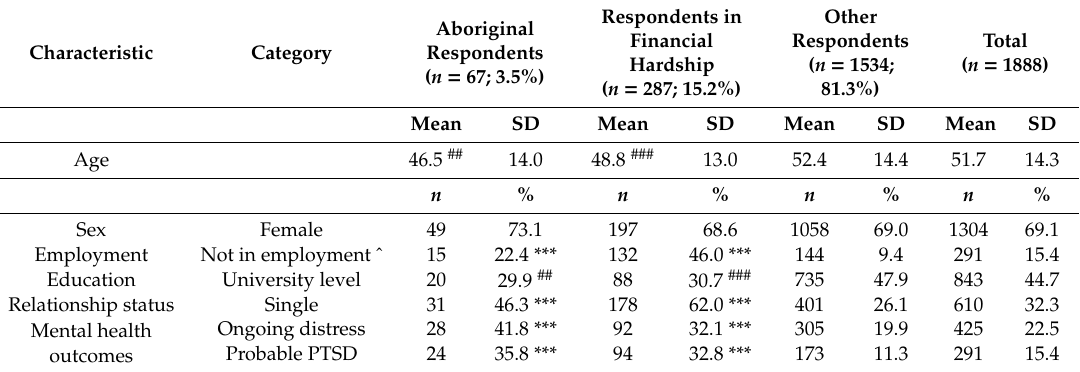
Table 3. Demographic profile and mental health outcomes by respondent group.